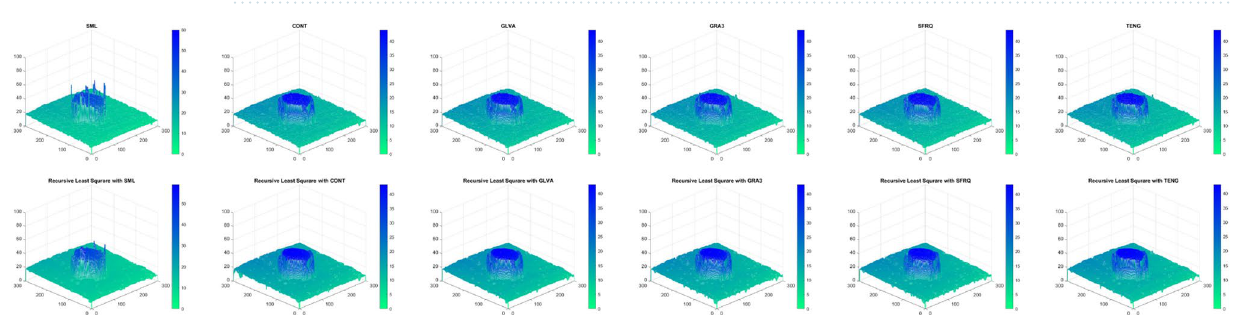
Figure 12. Shape reconstruction of Plane using FM with proposed RLS method. (left to right), SML, CONT, GLVA, GRA3,SFRQ, TENG. (top row) with FM only and (bottom row) using FM with RLS method.